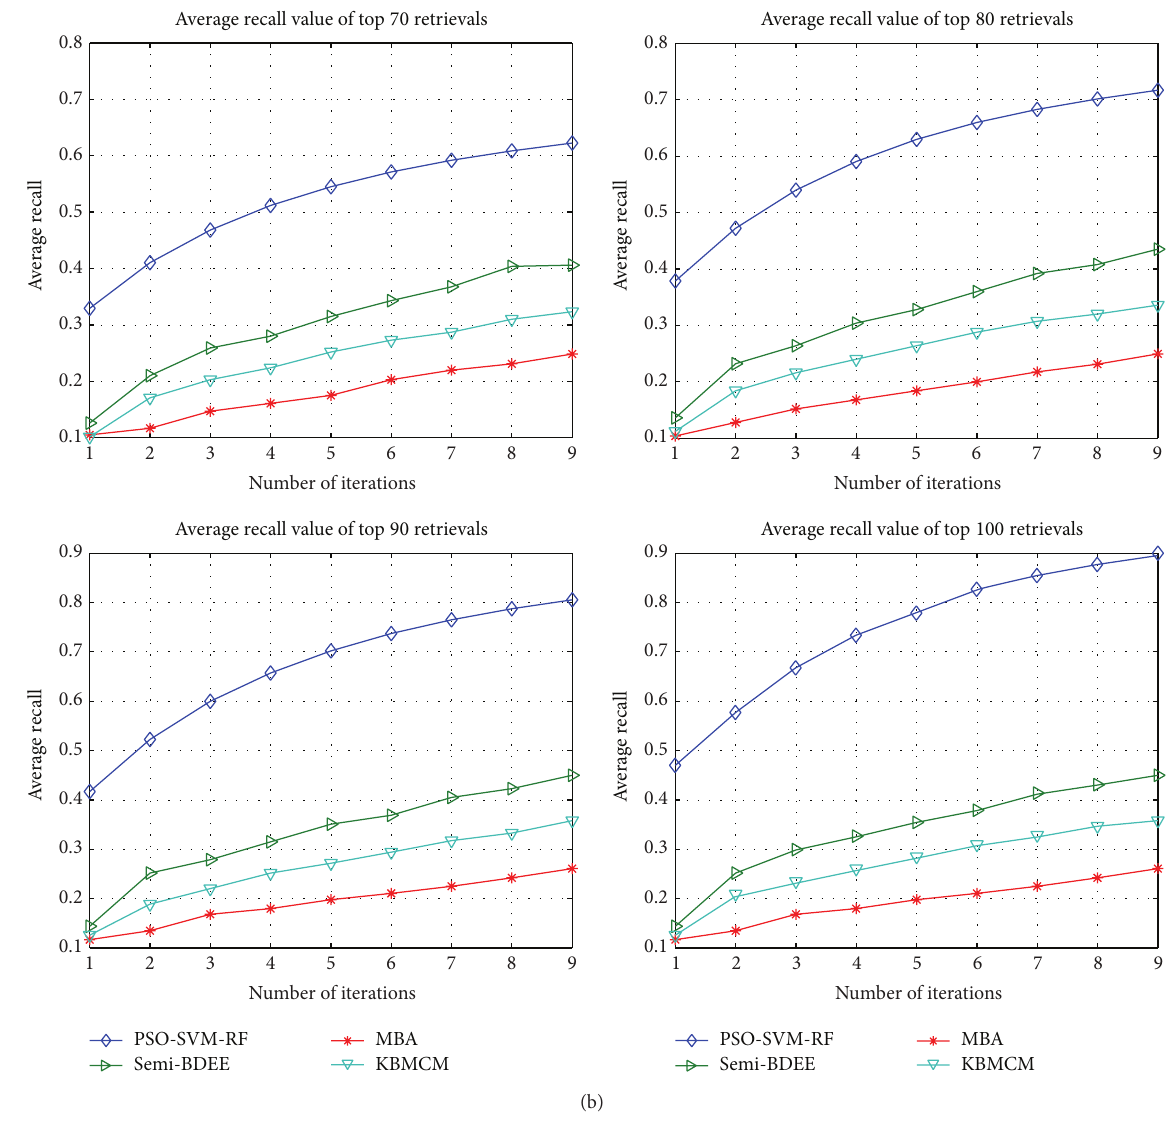
Figure 4: Recall based comparison of the proposed PSO-SVM-RF against representative of existing algorithms, that is, semi-BDEE, MBA, BDA, KBMCM, and ABRSVM. All algorithms are evaluated over nine RF